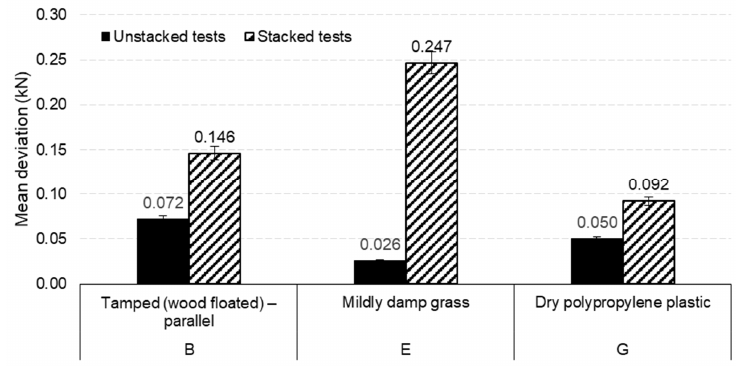
Figure 10. Mean deviation comparison—unstacked and stacked tests.